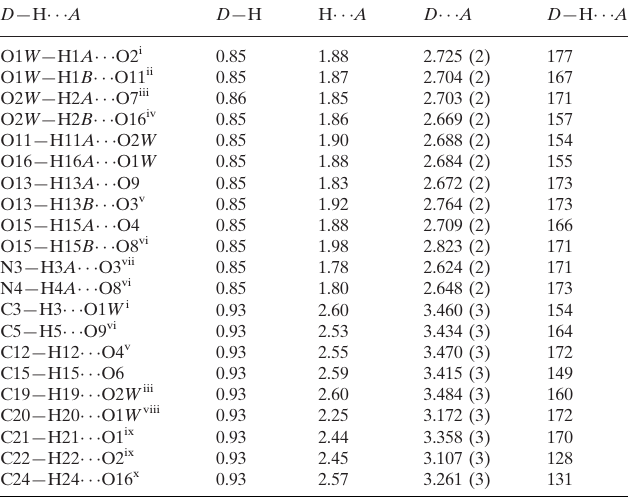
Hydrogen-bond geometry (A˚ , (cid:3)